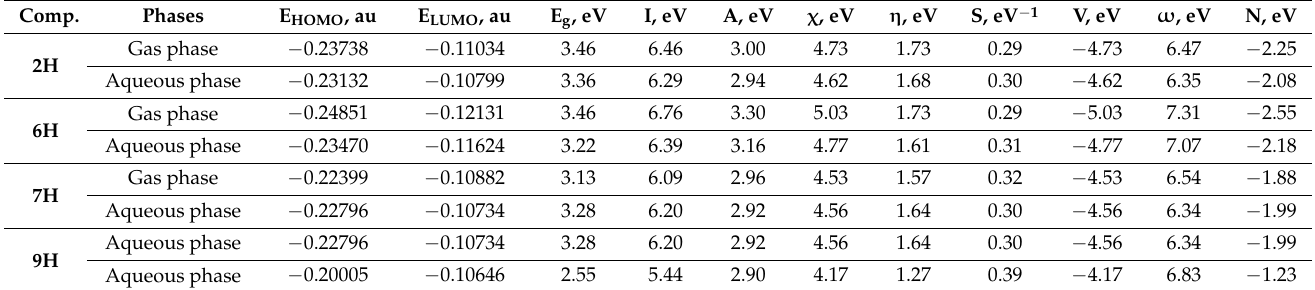
Table 3. Global reactivity descriptors of the ( 2H , 6H , 7H and 9H ) TUDHIPP derivatives at the B3lyp/6-311++G (d,p) level of calculation in the gas and aqueous